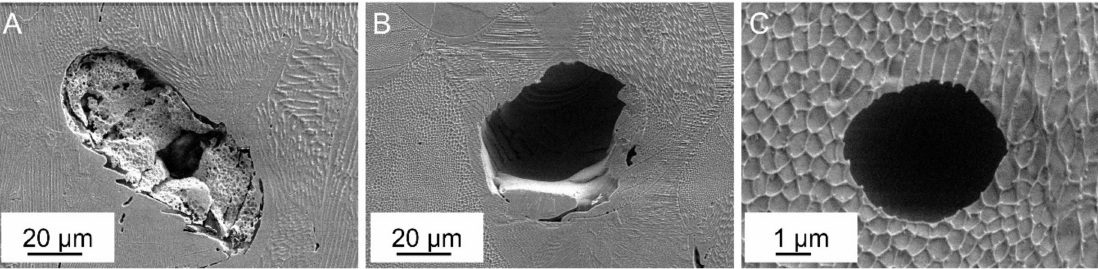
Figure 7. Detail on pore morphology. Keyhole pores ( A , B ) can present distinct morphologies and sizes. Gas pores ( C ) are present in all specimens.